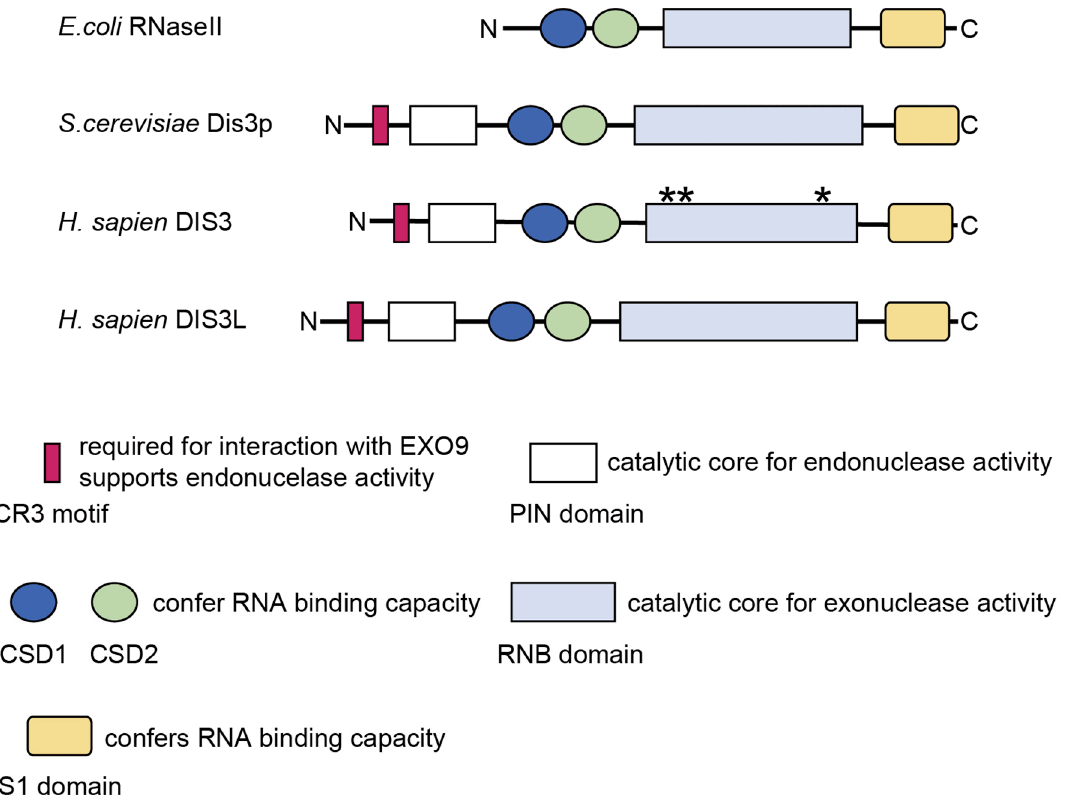
Figure 2. Motif and domains of the DIS3 protein family. Functions of each motif and domain are shown. PilT N-terminal (PIN) domain of DIS3L does not possess any endonuclease activity due to the lack of catalytic residues. Each of * indicates the position of the mutational hotspots in multiple myeloma, which are located in the RNB domain. CR3, Cysteine-Rich with three cysteines; CSD, cold-shock domain.